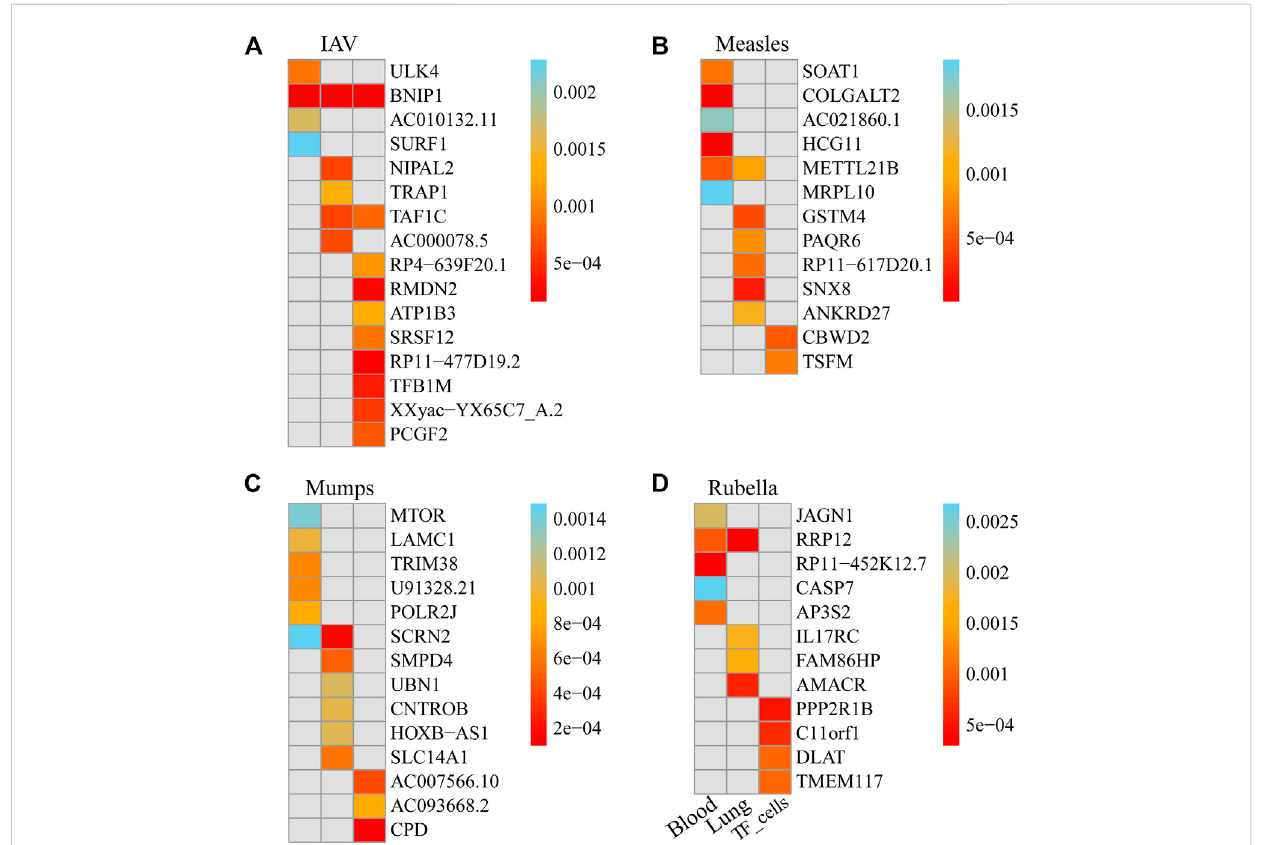
FIGURE 2 Genessigni fi cantlyassociatedwiththeriskoffourrespiratoryinfectiousdiseasesineachtissue. (A) .Genessigni fi cantlyassociatedwiththeriskofIAV ineach tissue. (B) . Genessigni fi cantly associated with therisk of measles ineachtissue. (C) . Genessigni fi cantly associated with the riskof mumps in each tissue. (D) . Genes signi fi cantly associated with the risk of rubella in each